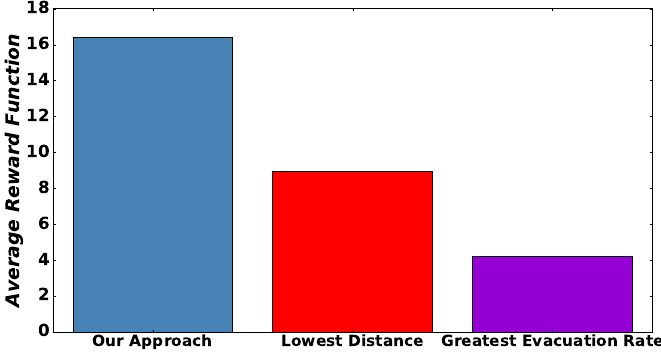
Figure 7. Comparative analysis—Scenario 3: average reward function of all alternative